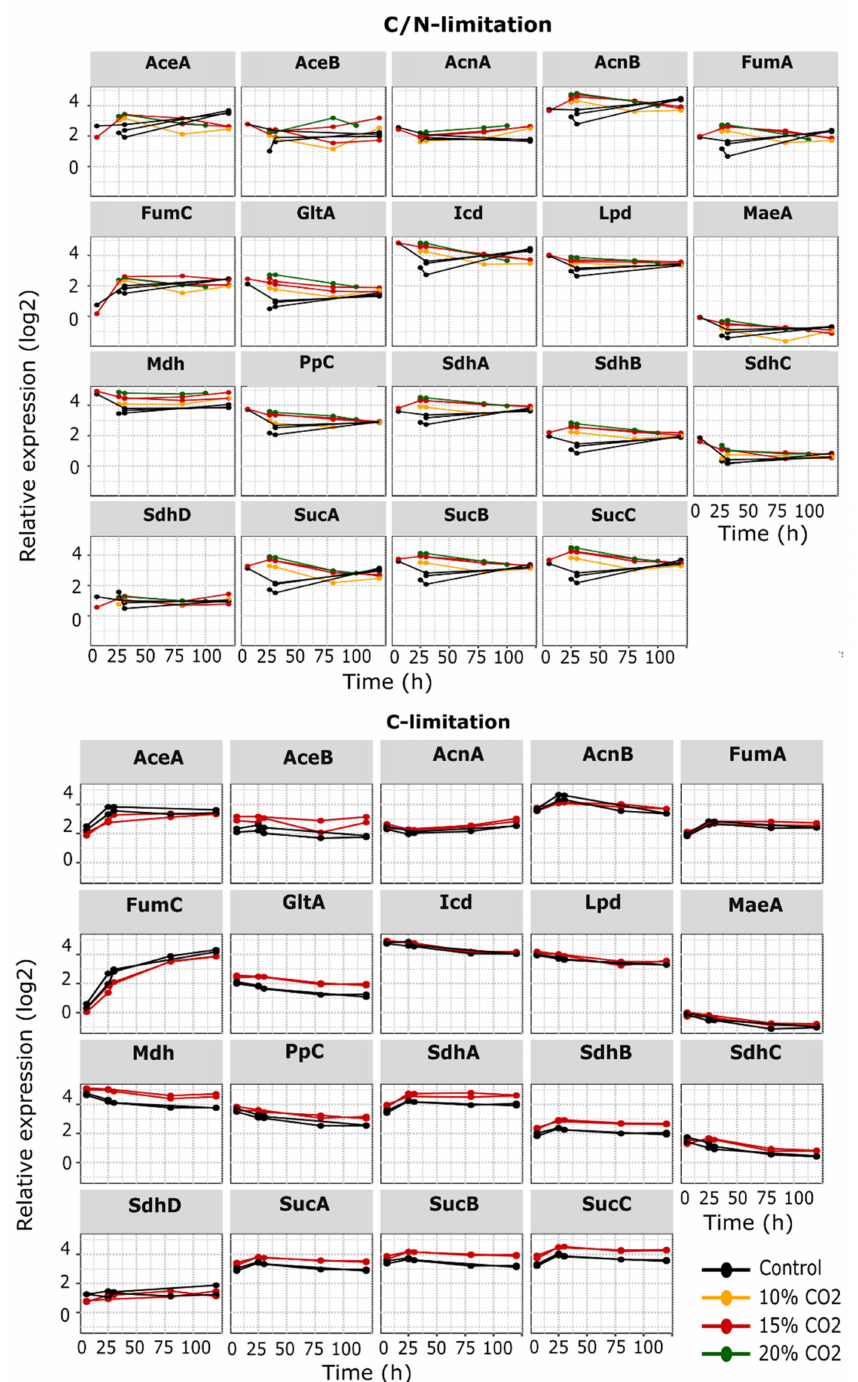
Figure 9. Protein expression level in the TCA cycle under different fermentation conditions: C/N- lim- ited with 0%, 10%, 15%, and 20% pCO 2 enrichment and C-limited with 0% and 15% pCO 2 enrichment. Y -axis = relative expression in log2, X -axis = fermentation age after feed start in hours. AceB: malate synthase A, AceK: isocitrate dehydrogenase kinase, AcnA: aconitate hydratase A, AcnB: aconitate hydratase, FumA: fumarase A, FumC: Fumarate hydratase, GltA: citrate synthase, Icd: